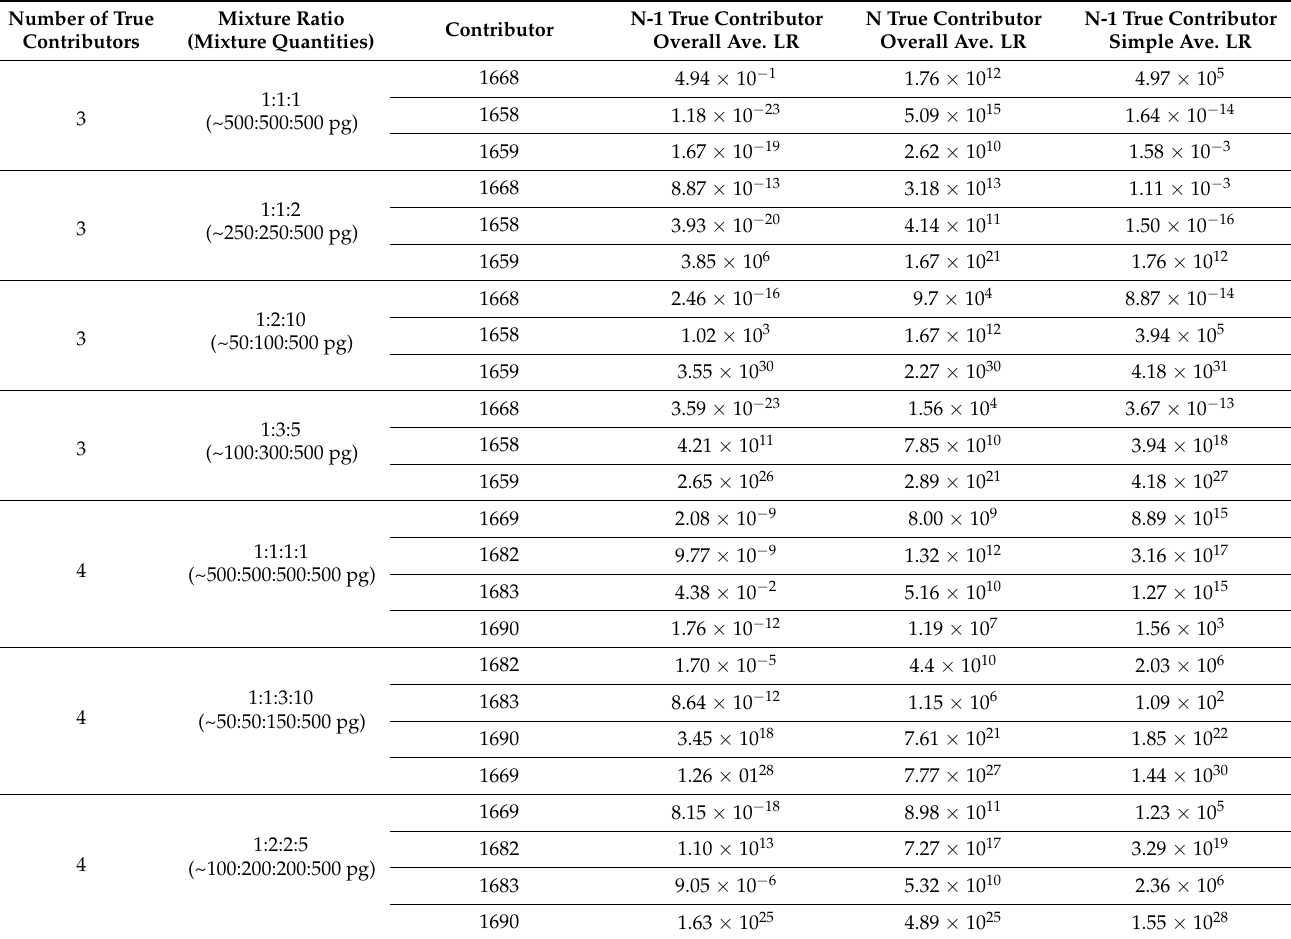
Table 5. Summary of the average (N = 5) calculated LR results of the N-1 NOC tests for each of the component contributors in its respective mixture. The contributors in each mixture are listed in the order of the position and ratio that they occupied in the mixture. The four-person mixtures altered the sample order, depending on the ratio being tested, for additional variability. All data shown are from undiluted samples, with the approximate quantities of DNA template in each mixture indicated. Overall (sub-sub-source) LRs consider the position of the individual contributor in the mixture, while simple (sub-source) LRs do not. The average overall (sub-sub-source) LR values for each mixture contributor calculated with the true NOC is included for comparison.